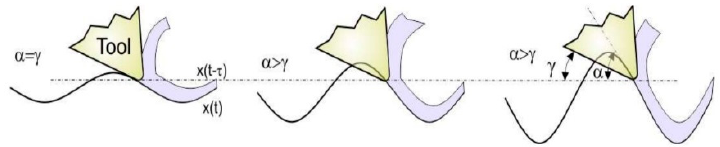
Figure 6. Process damping due to rubbing of the flank face with the wavy surface left [10,18].